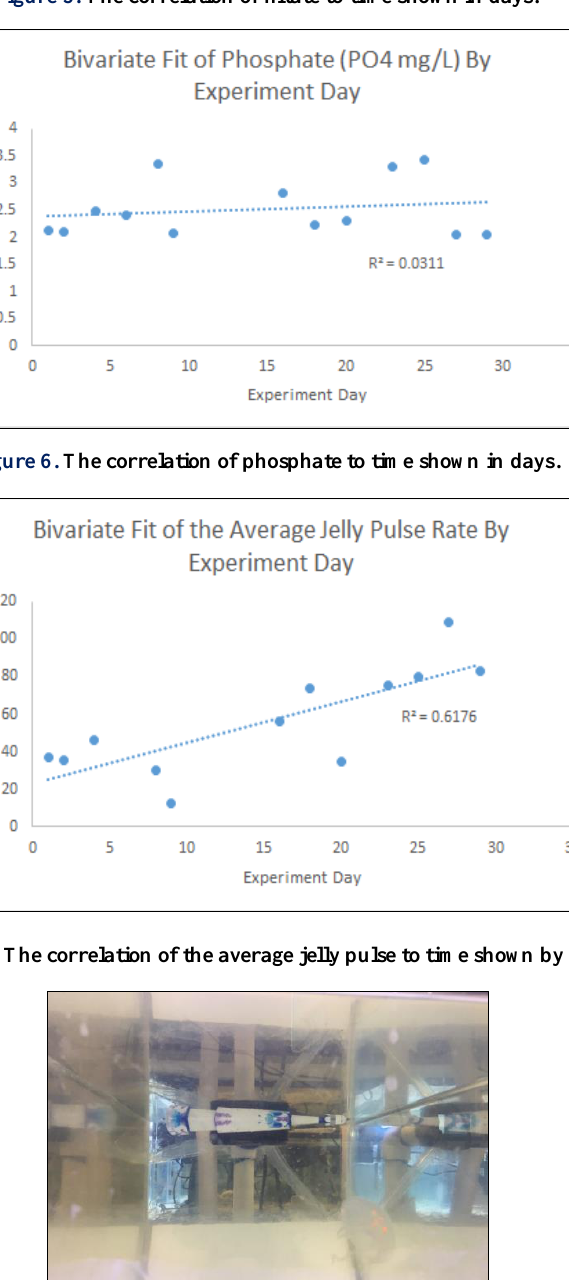
Figure 5. The correlation of nitate to time shown in days.